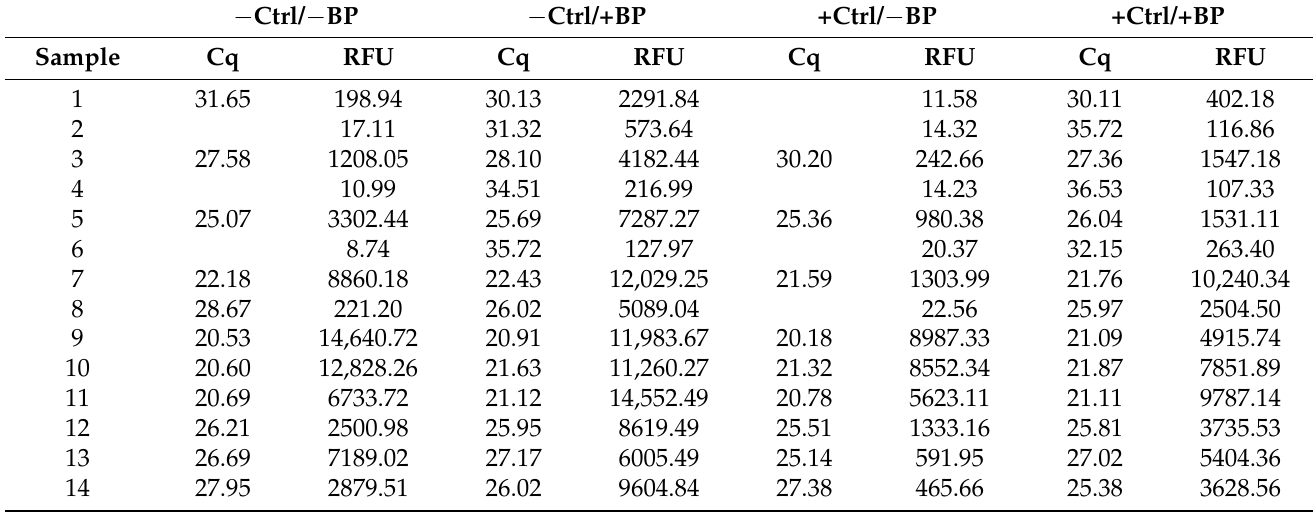
Table 5. Real-time PCR results of ratios (1 H. armigera leg: 50 H. zea legs) with and without bead purification (BP) and presence and absence of 18S control primers and probe (Ctrl). Blank entries in “Cq” columns indicate false negative